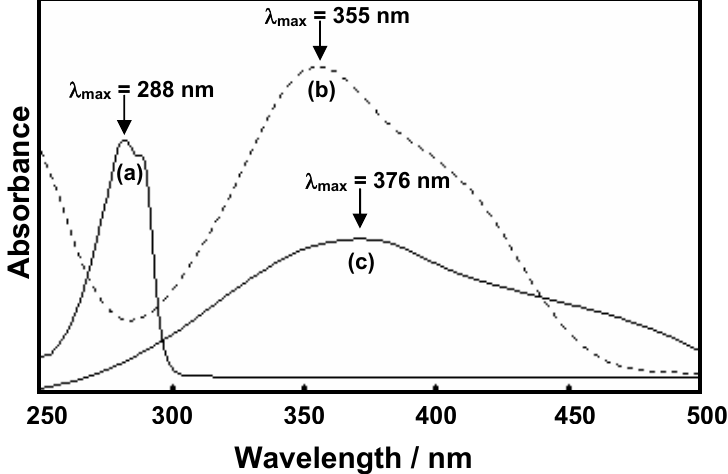
Figure 4. UV-Vis absorption spectra of (a) BM1 , (b) Na + -picrate, and (c) complex of BM1 and Na + ions.